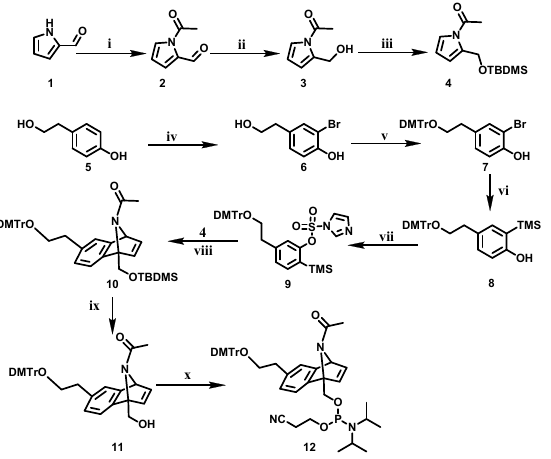
Scheme 1. Synthesis of benzonorbonadiene linker phosphoramidite (i) acyl chloride, N , N -diisopro- pylethylamine (DIPEA), 4-dimethylaminopyridine (DMAP), DCM, r.t., 12 h; (ii) Zn(BH 4 ) 2 , THF, 0